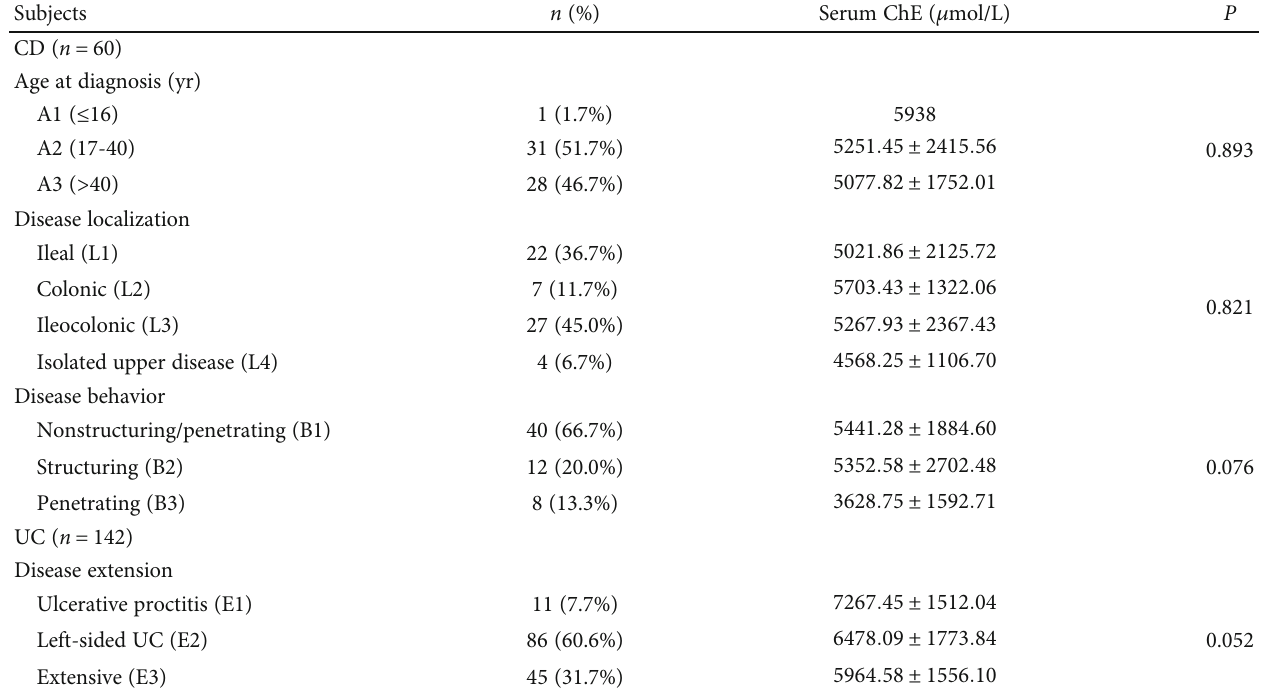
Table 2: Relationship between phenotype characteristics and serum ChE levels of patients with